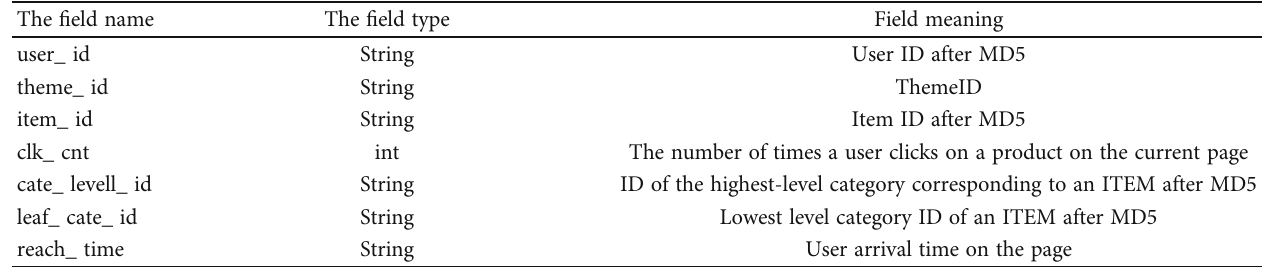
Table 5: Fields contained in data set.